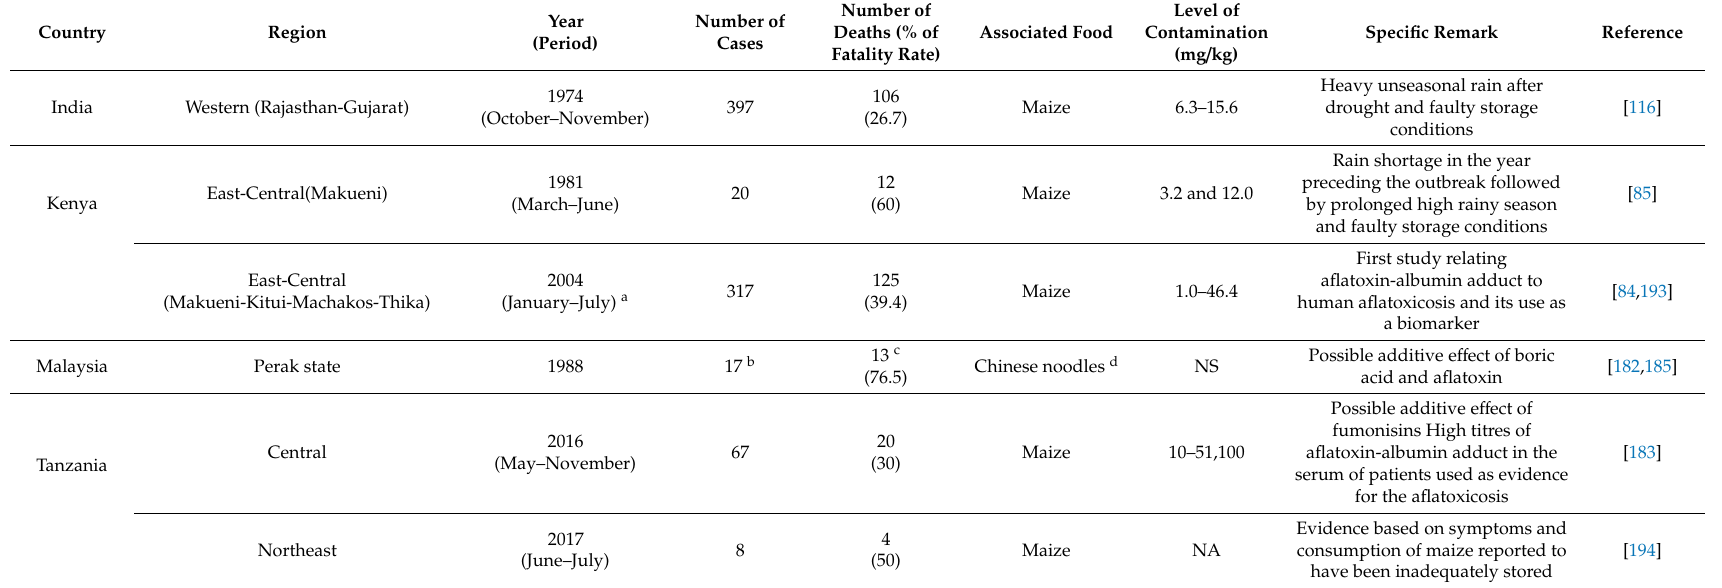
Table 7. Significant aflatoxicosis outbreaks in Asia and